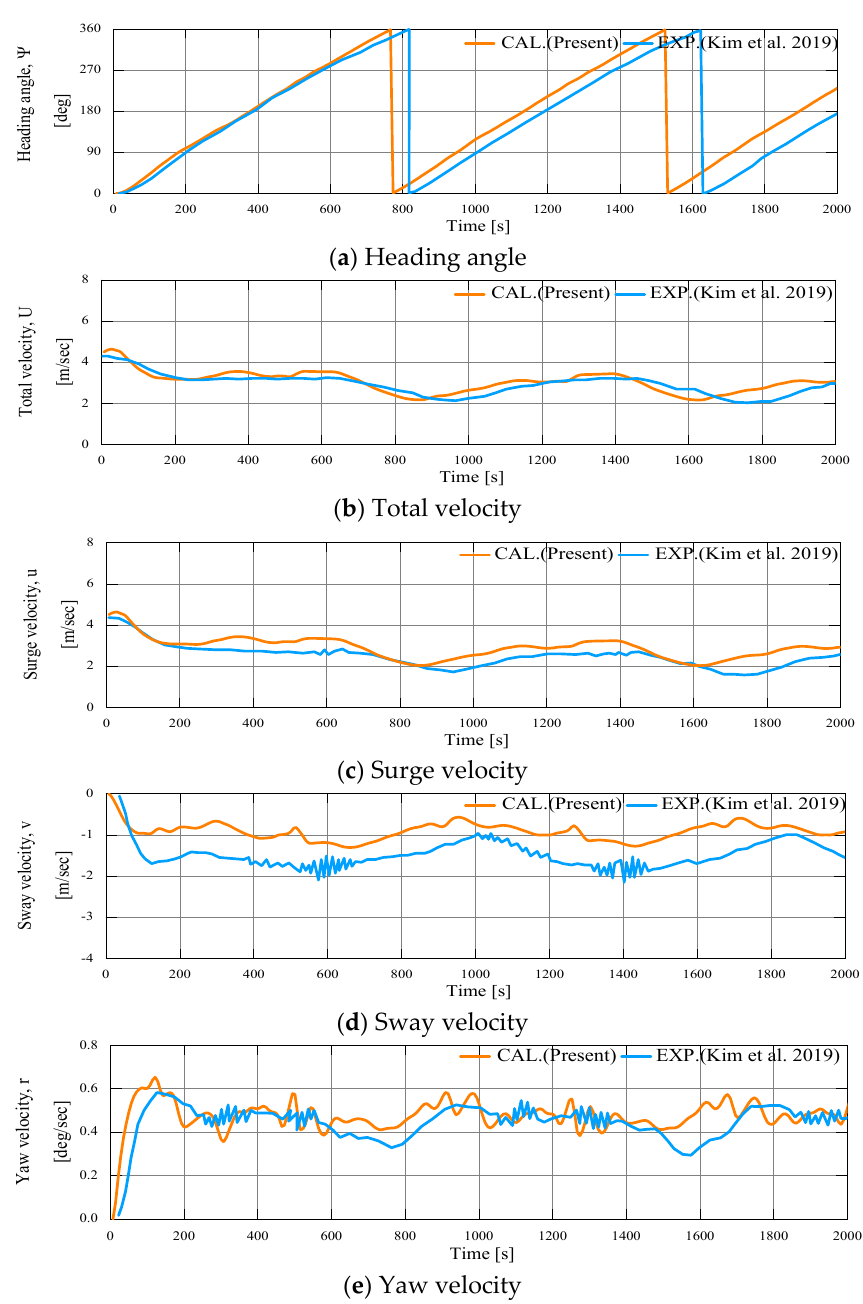
Figure 20. Comparisons of heading angle, surge, sway, yaw, and total velocity of the KVLCC2 under +35° turns. The experimental values were reproduced from [8], with permission from Elsevier, 2022.